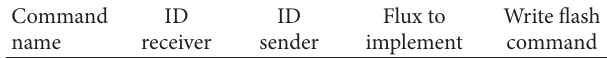
Table 5: Typical transmitted